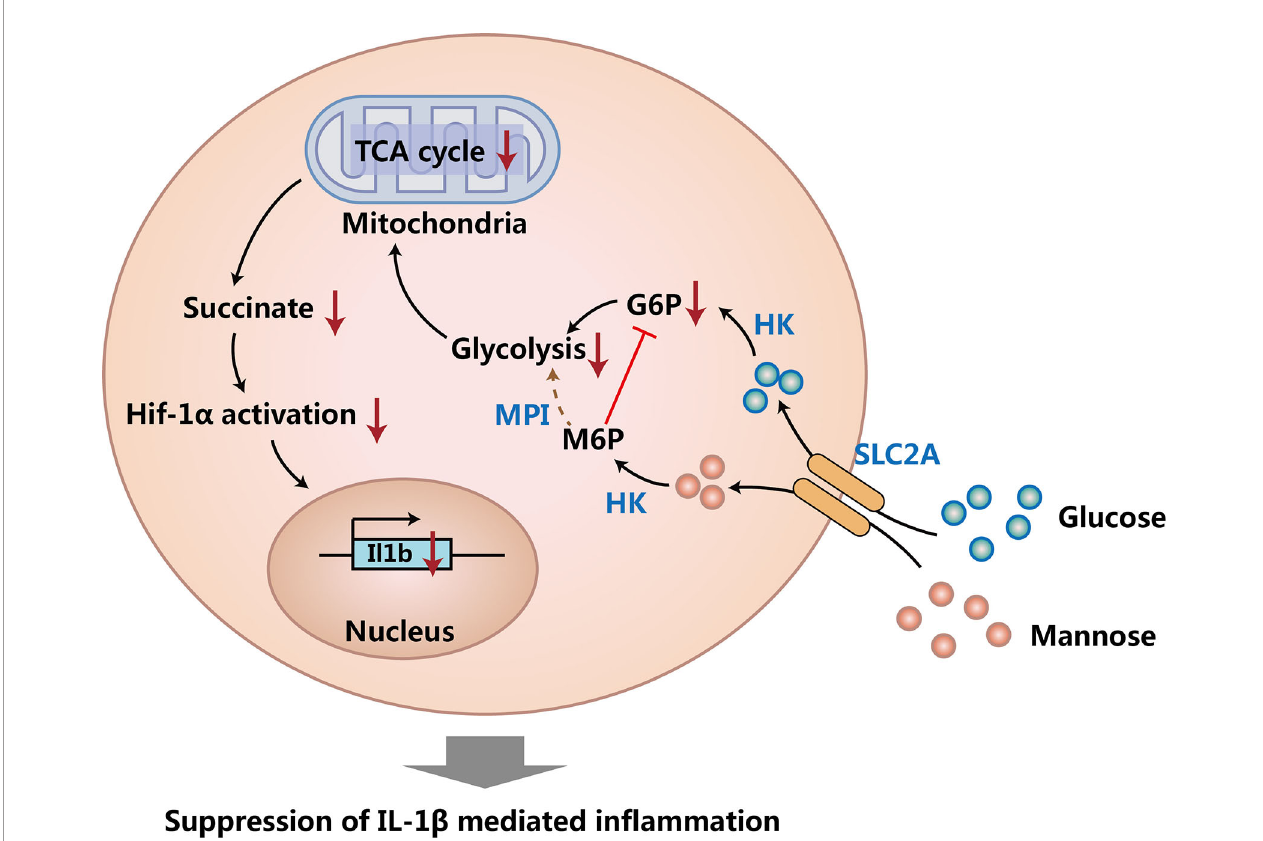
FIGURE 2 | Mannose suppresses macrophage IL-1 b production. Mannose and glucose share the same transporter (SLC2A) and can be converted to mannose 6-phosphate (M6P) and glucose 6-phosphate (G6P) respectively by hexokinase (HK). The process of M6P generation suppresses glycolysis by reducing G6P, and M6P cannot be used for glycolysis ef fi ciently due to the low expression of phosphomannose isomerase (MPI) in macrophages. Suppressed glycolysis causes reduced tricarboxylic acid (TCA) cycle and decreases the production of succinate. Decreased succinate reduces succinate-mediated HIF-1 a activation, and then causes the decreased expression of IL-1 b in